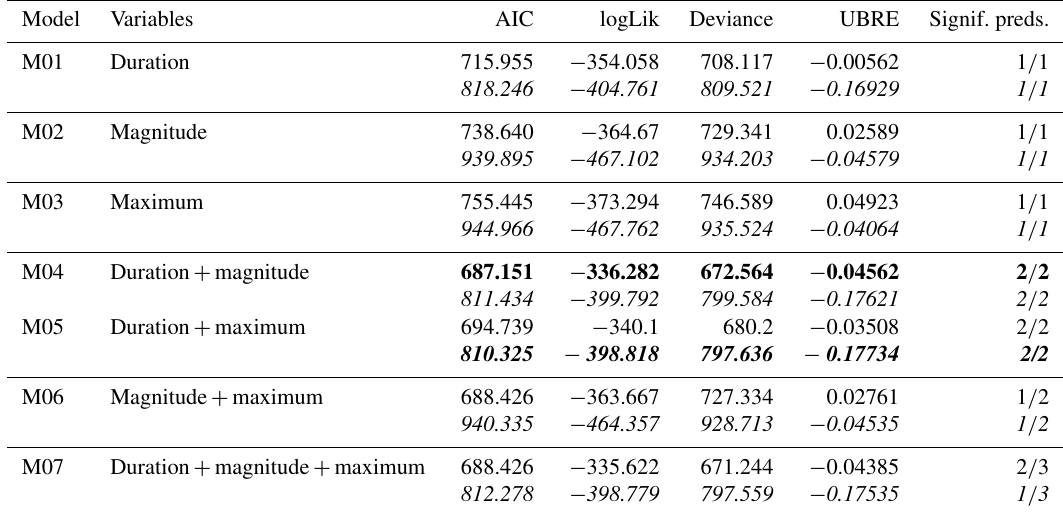
Table A1. Accuracy assessment of the models for Algeciras (regular text) and Upper Mula (italic text). Goodness-of-fit measures: AIC (Akaike information criterion), logLik (log-likelihood), deviance (residual deviance), UBRE (unbiased risk estimator), and number of sig- nificant predictors. Bold text indicates the values of the selected model.